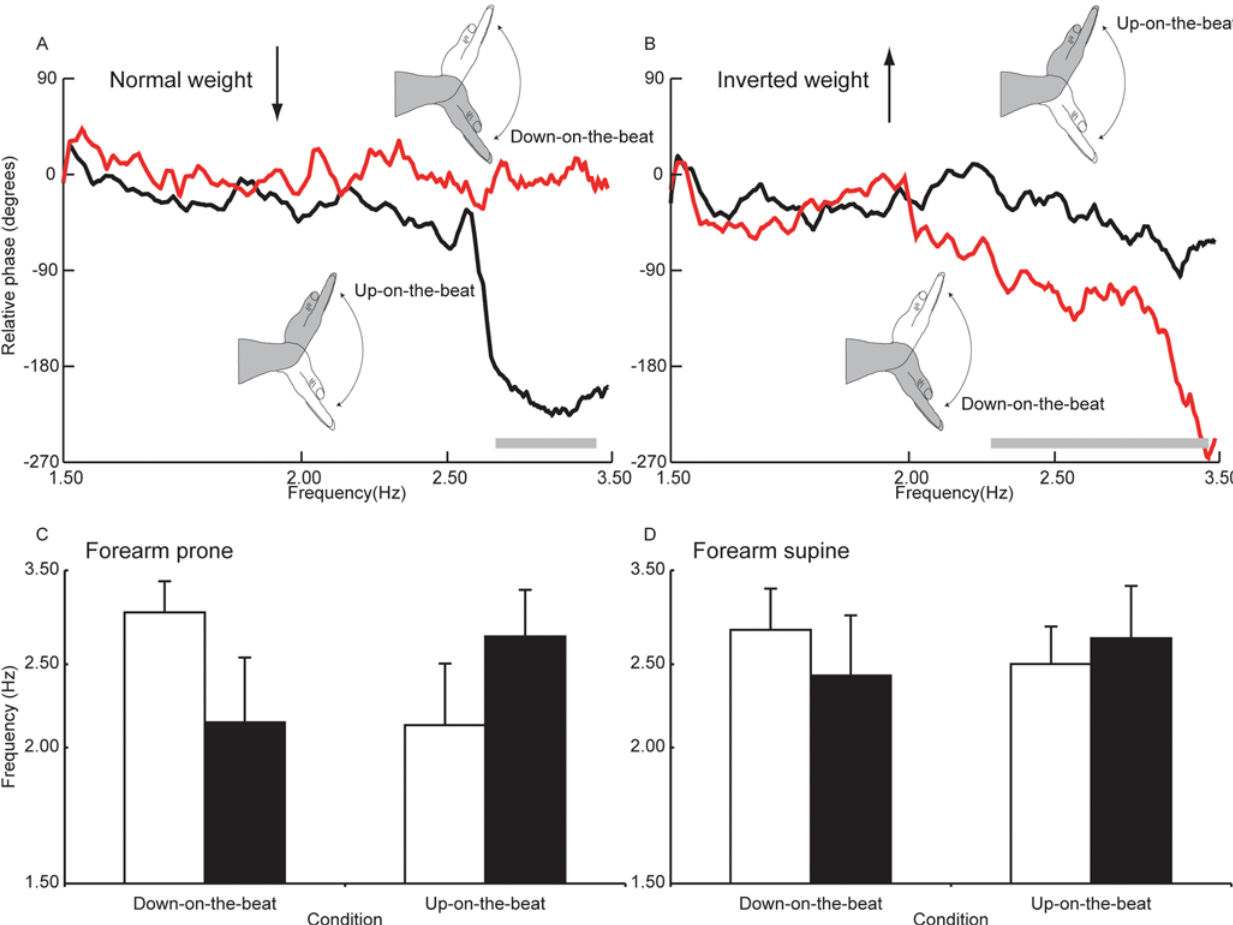
Figure 1. Influence of inversion of hand weight on the stability of coordination. (A) For this participant, when the gravitational torque was normal and the forearm supine, the down-on-the-beat pattern (red trace – mean of 6 trials) remained stable throughout. The up-on-the-beat pattern (black trace) became unstable initially at around 2.6 Hz, and the down-on-the-beat pattern was then adopted. (B) When the weight of the hand was inverted, the down-on-the-beat pattern was not maintained reliably beyond 2.25 Hz. In the up-on-the-beat trials no such loss of stability was exhibited. The grey horizontal bars indicate the range of frequencies across which a loss of stability occurred. (C). Mean frequency at the loss of stability (n=8 participants) when the forearm was prone (open bars – normal weight; filled bars – weight inverted). Error bars represent means of the 95% confidence intervals obtained for the individual participants. (D) Mean frequency at the loss of stability when the forearm was supine.